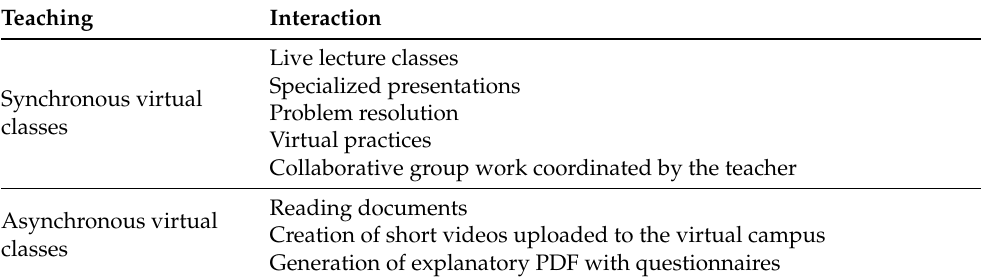
Table 3. Off-campus teaching methodologies.